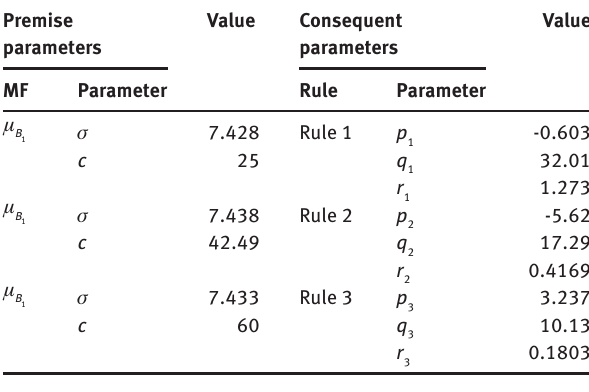
Table 6 Values of premise and consequent parameters in proposed ANFIS structure.